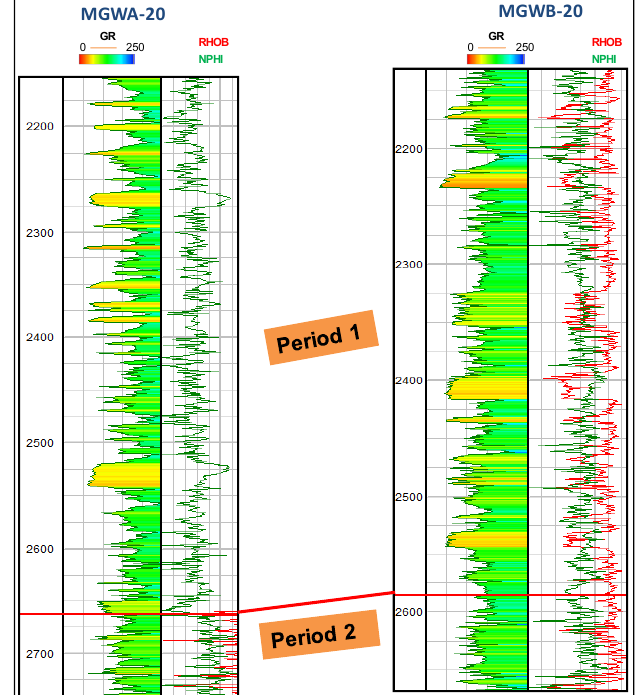
Figure 11: Wire line character of depositional sequences of period